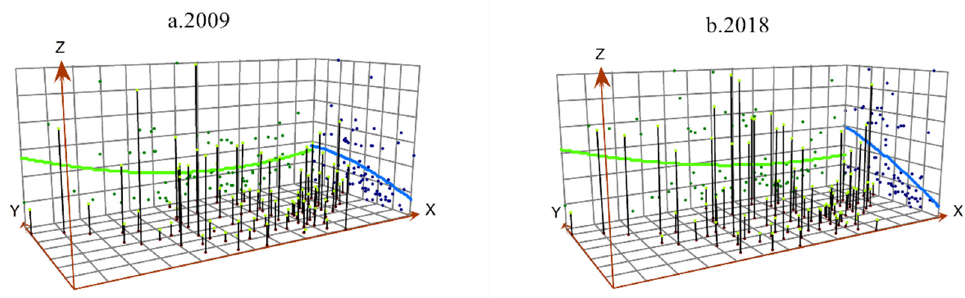
Figure 7. The overall trend of LUE in the Yellow River Basin from 2009 to 2018.